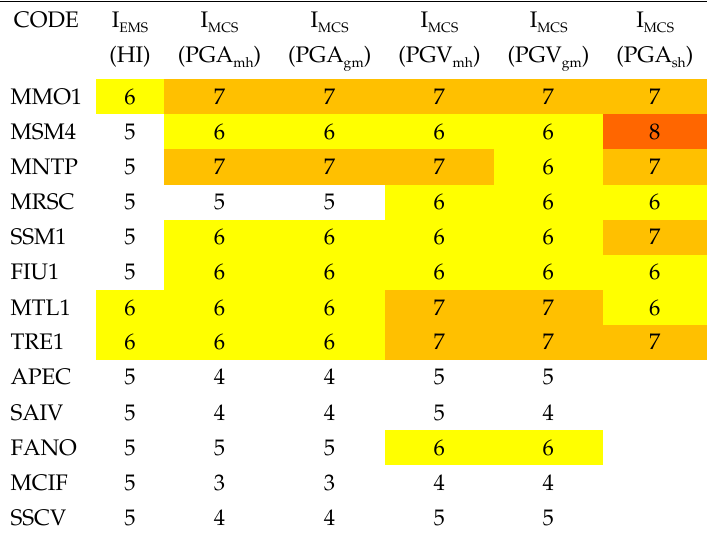
(HI): intensity from HI EMS MCS (PGV ): intensity MCS gm (PGA ) punctual values of MCS sh